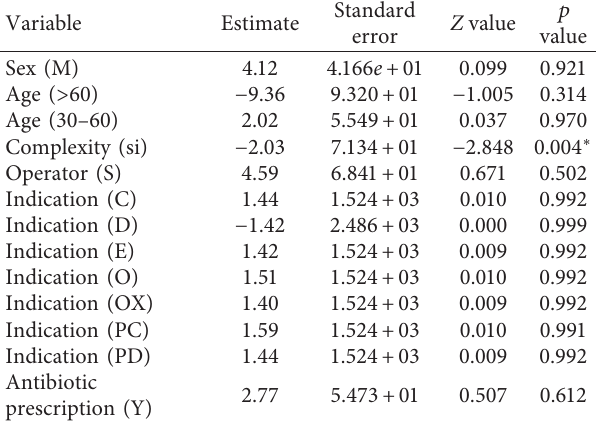
Table 5: Binomial logistic regression with postoperative infection as the dependent